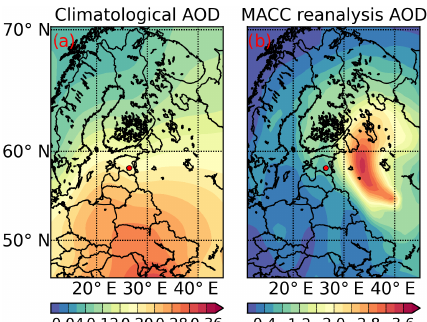
Figure 1. (a) AOD550 for August in the default climatology in the ALADIN-HIRLAM NWP system (Tegen et al., 1997). (b) AOD for 8 August 2010 from the MACC reanalysis (Inness et al., 2013). The location of Tõravere (58.3 ◦ N, 26.5 ◦ E), for which the MUSC single-column experiments are run, is shown as a red dot in both panels. Note the factor of 10 difference in AOD between the Tegen climatology and the MACC